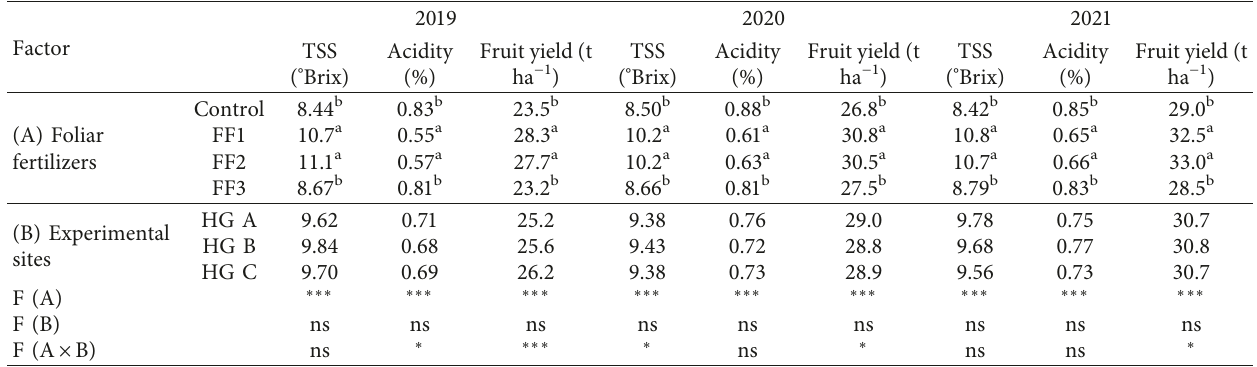
Table 4: Influence of treatments on the pomelo yield and fruit quality.